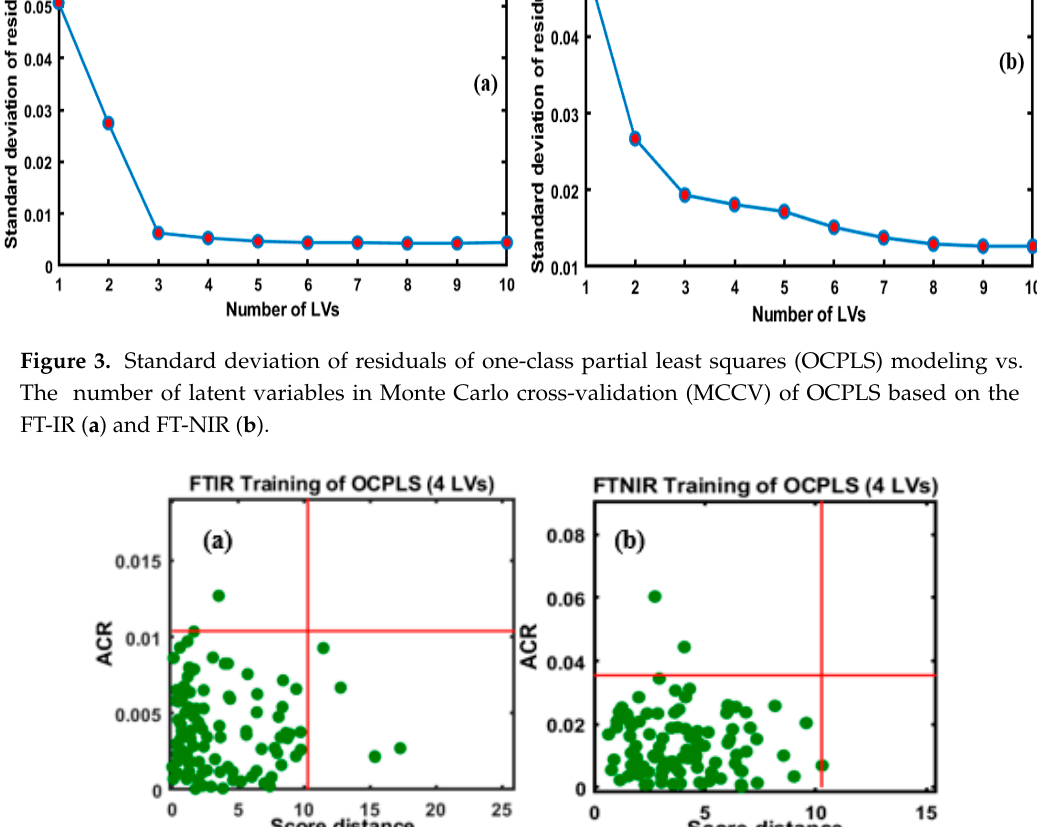
Figure 4. OCPLS-based calibration models for the ( a ) FT-IR and ( b ) FT-NIR data sets.